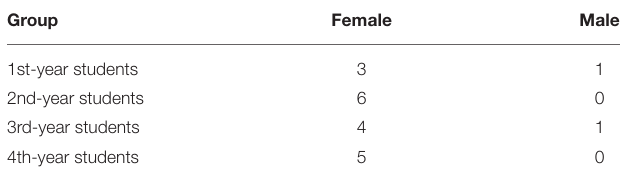
TABLE 1 | Patient demographics. Group